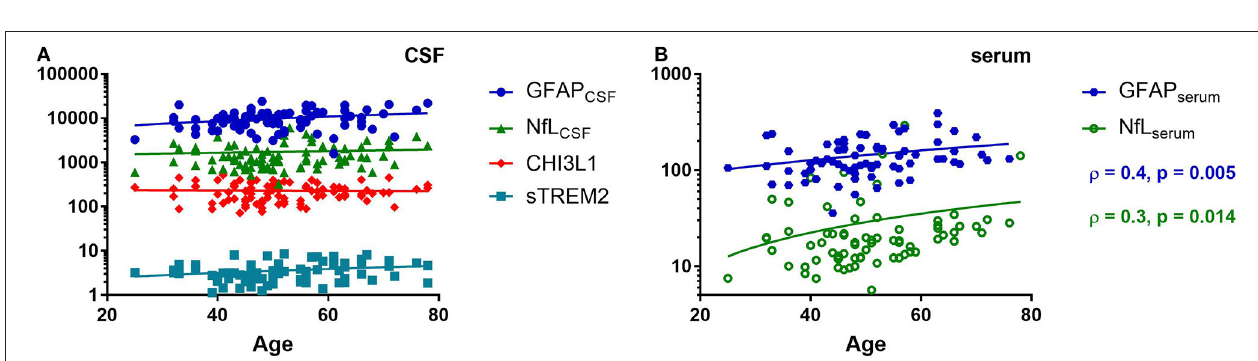
FIGURE 2 | Spearman correlation of various cerebrospinal fluid (CSF) (A) and serum (B) biomarkers with the age of the patients. Glial fibrillary acidic protein (GFAP), neurofilaments light chain (NfL), chitinase 3 like 1 (CHI3L1), soluble triggering receptor expressed on myeloid cells 2 (sTREM2), ρ (Spearman rho).